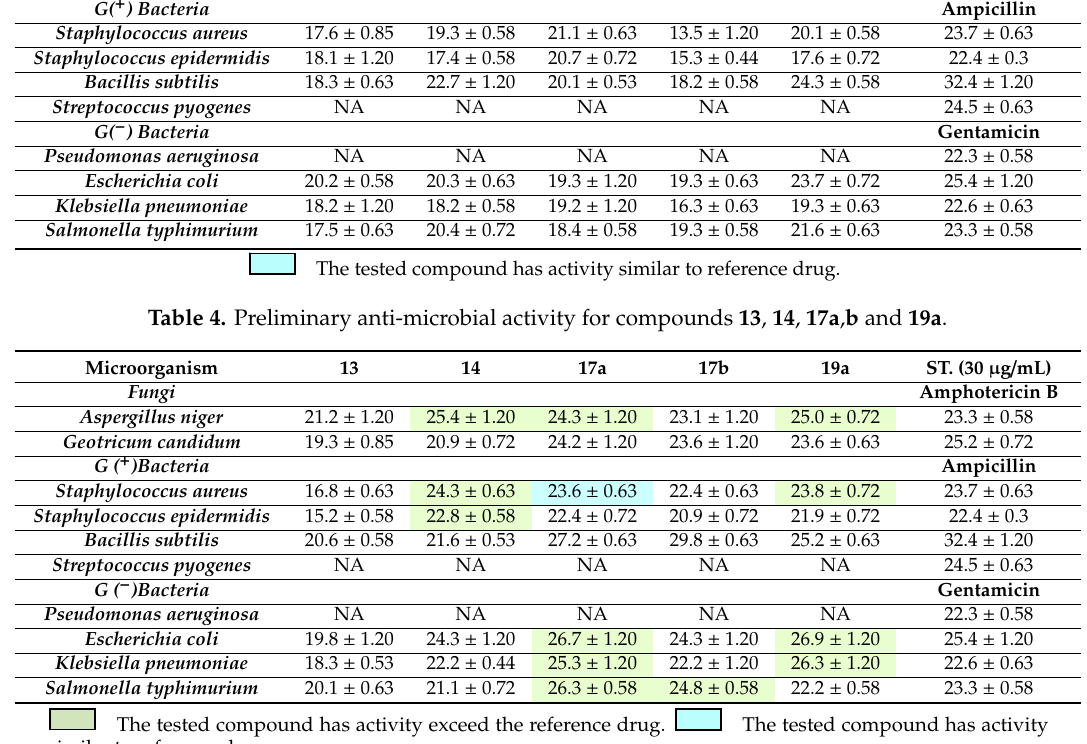
Table 4. Preliminary anti-microbial activity for compounds 13 , 14 , 17a , b and 19a . Table 5. Preliminary anti-microbial activity for compounds 19c – f and 21a . Table 3. Preliminary anti-microbial activity for compounds 2 , 6 – 8 , 12 . Table 5. Preliminary anti-microbial activity for compounds 19c – f and 21a .